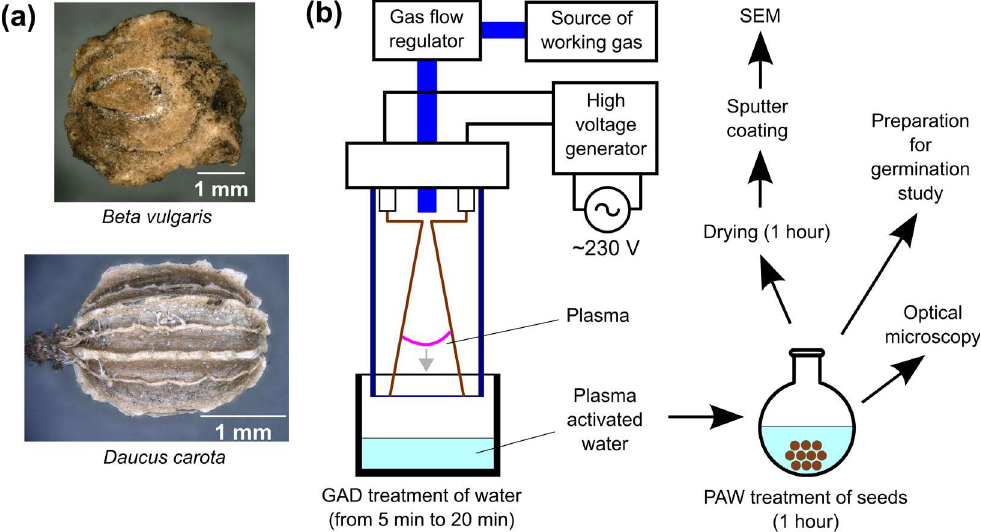
Figure 1. ( a ) Photographs of treated seeds, ( b ) schematic of the